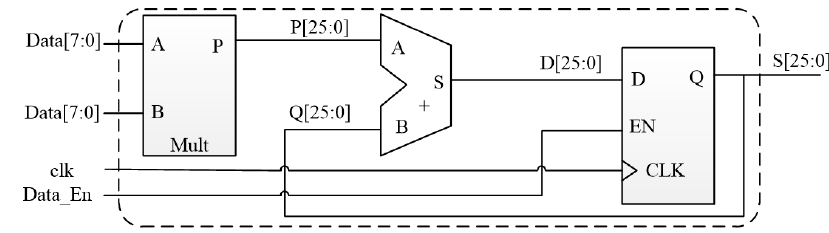
Figure 14. Sum of squares calculation unit of the reference sub-area.